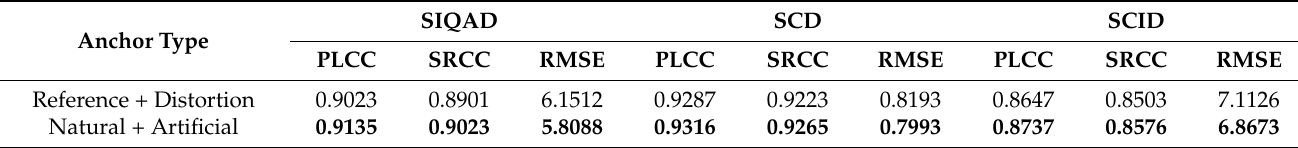
Table 8. Prediction performance with different anchor